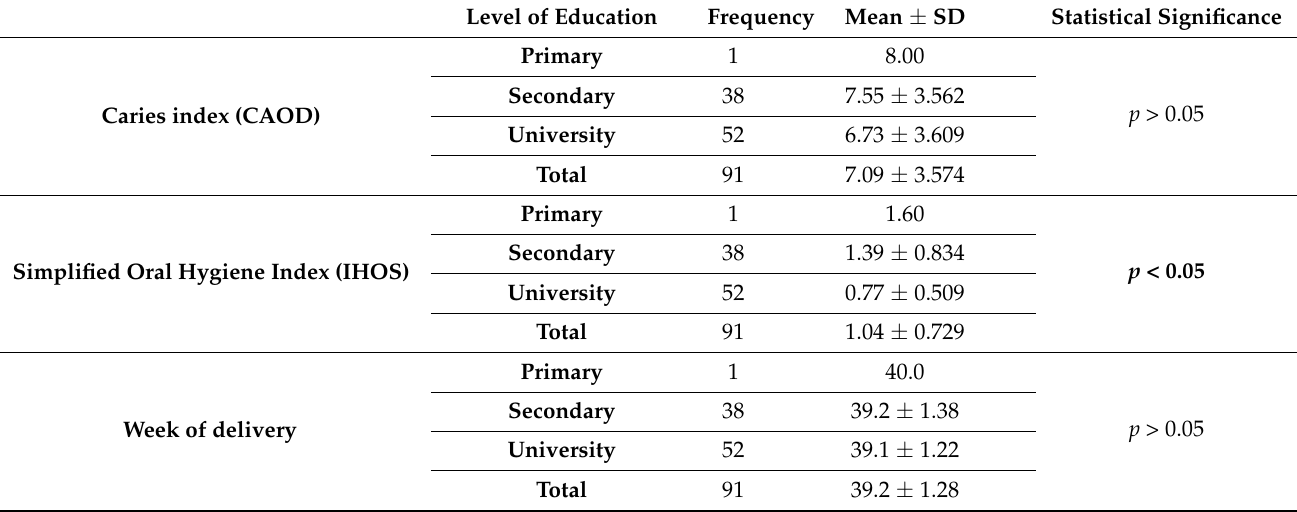
Table 4. Normal analysis of variance (ANOVA) of the variables studied according to educational